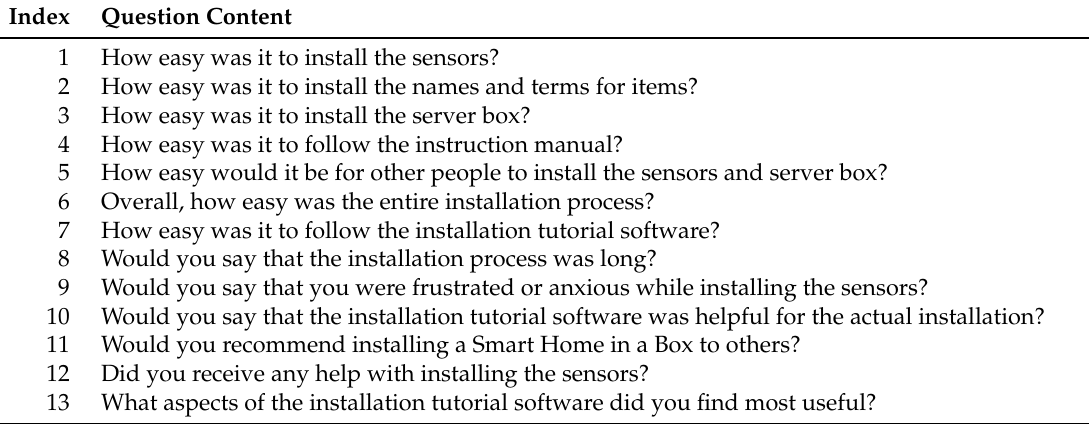
Table 1. Post-survey